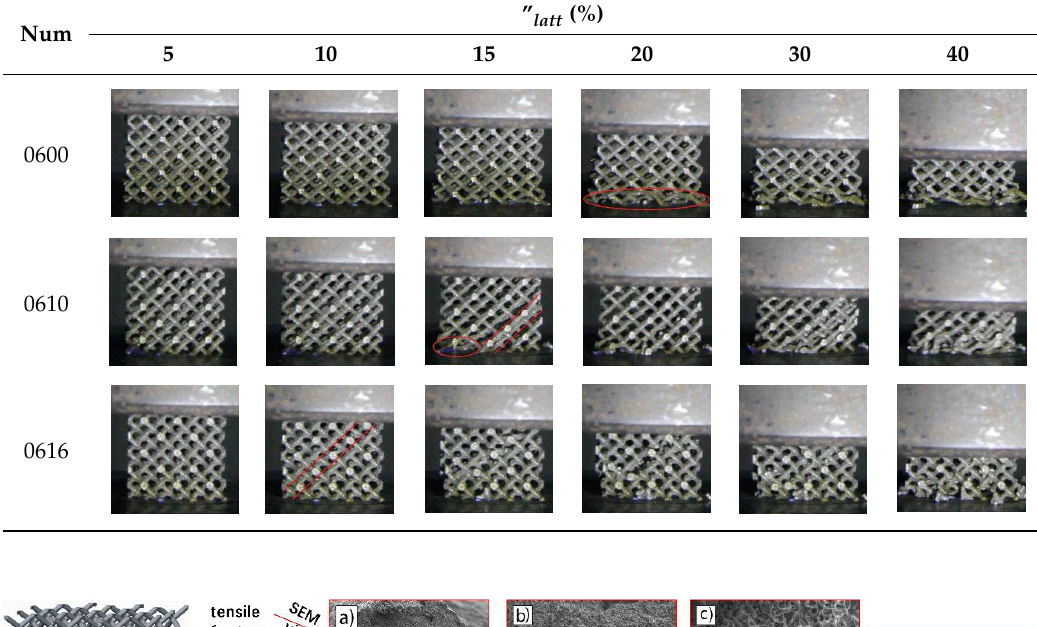
Table 5. Video frames of samples at several regions during compression.